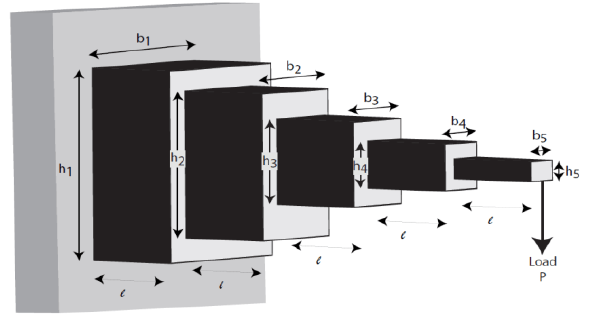
Figure 3. Stepped cantilever beam design